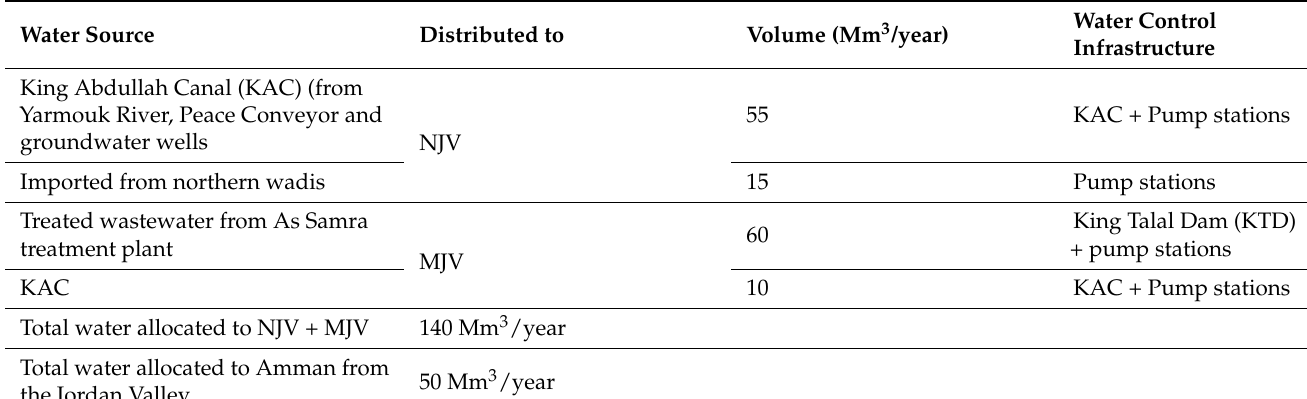
Table 4. Water allocation to the Northern Jordan Valley (NJV) and Middle Jordan Valley (MJV) (source: [23]).